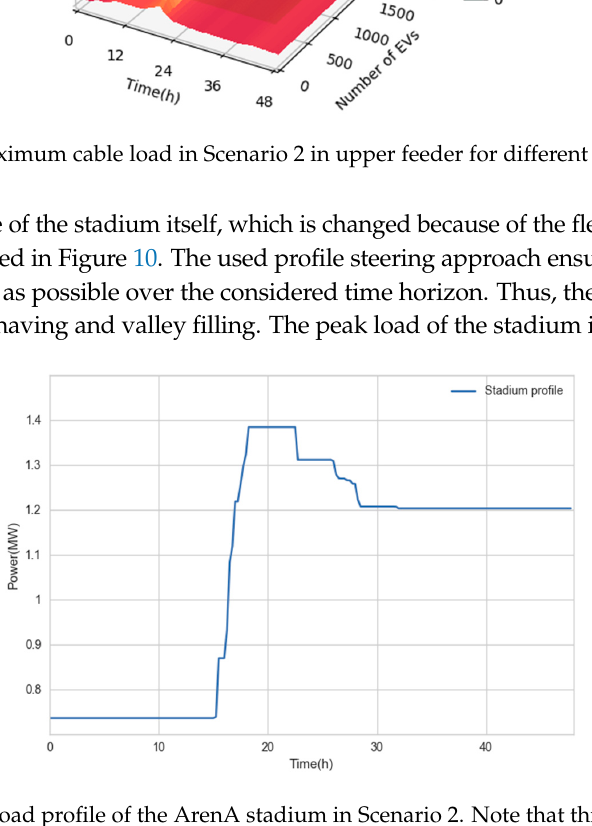
Figure 10. The total load profile of the ArenA stadium in Scenario 2. Note that this profile is the same for any number of EVs present.